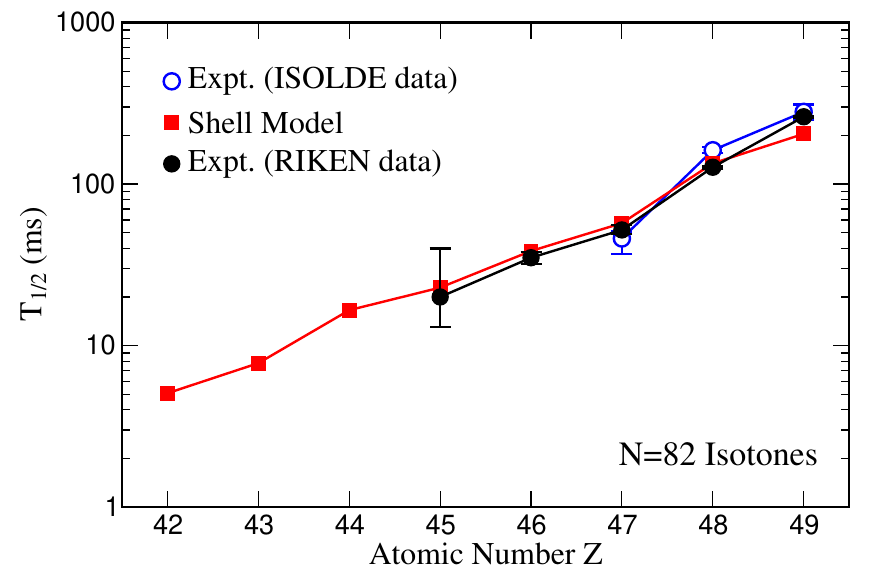
Figure 3. Comparison of shell model half lives for neutron number N = 82 r-process (rapid neutron- capture process) waiting point nuclei with data [86,98–100]. The GT strengths underlying the shell model results have been quenched with the standard factor of ( 0.74 ) 2 [30]. Taken from